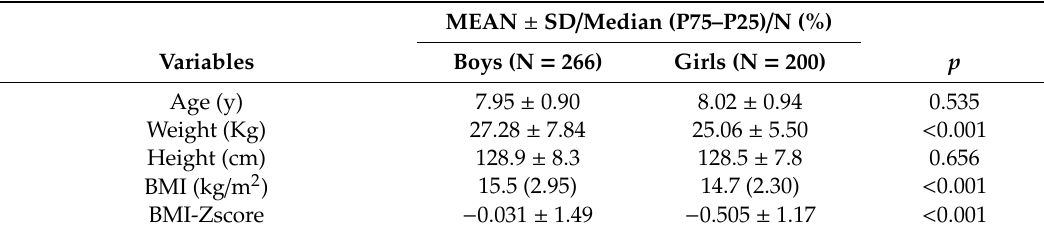
Table 1. Characteristics of the study